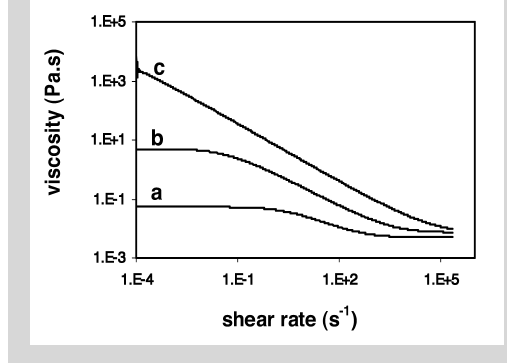
Figure 15: Steady viscosity versus g · : (a) [0.35, 2·10 -3 , 20], (b) [0.4, 4·10 -3 , 500], (c) [0.4057, 4·10 -3 ,